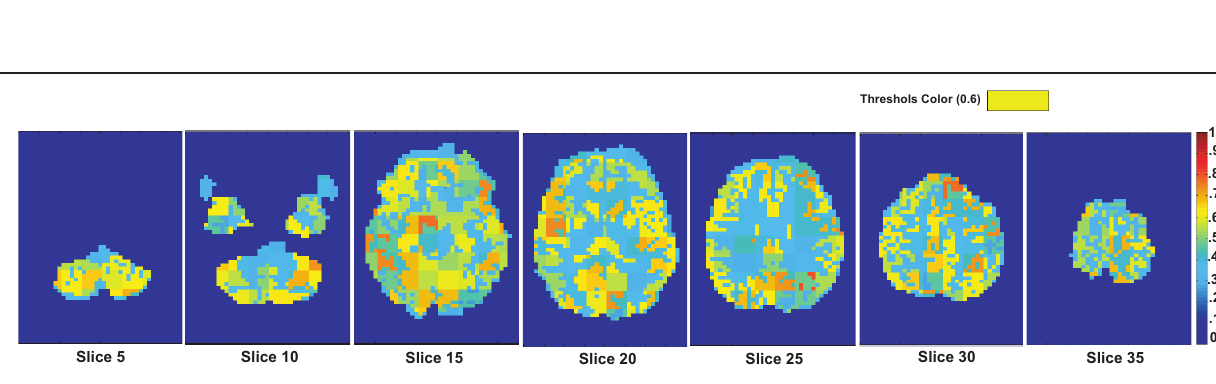
Frontiers in Systems